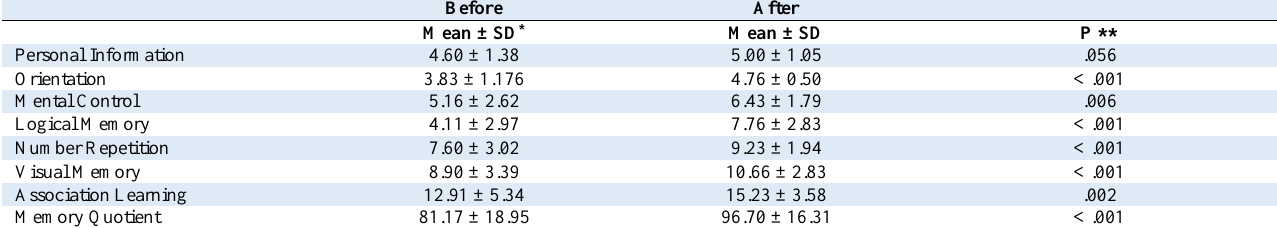
Table 2. Comparison of memory function before and after heroin abstinence